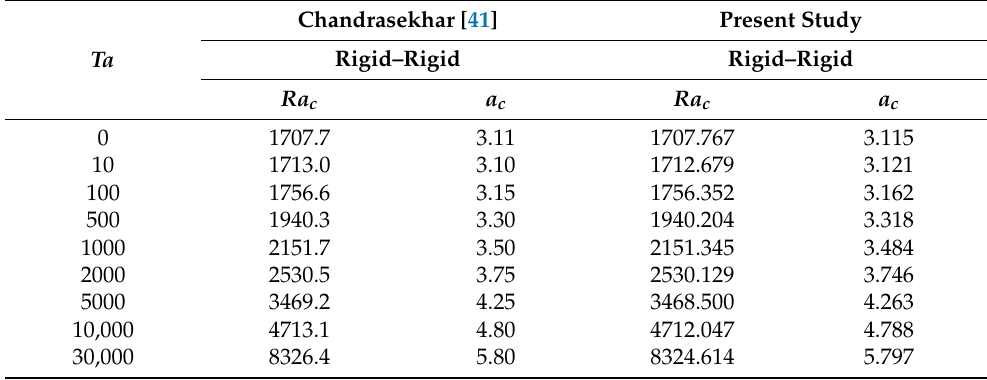
Table 2. Comparison between the present article’s results with existing results for Rigid–rigid boundary conditions for limiting case of sparsely packed porous